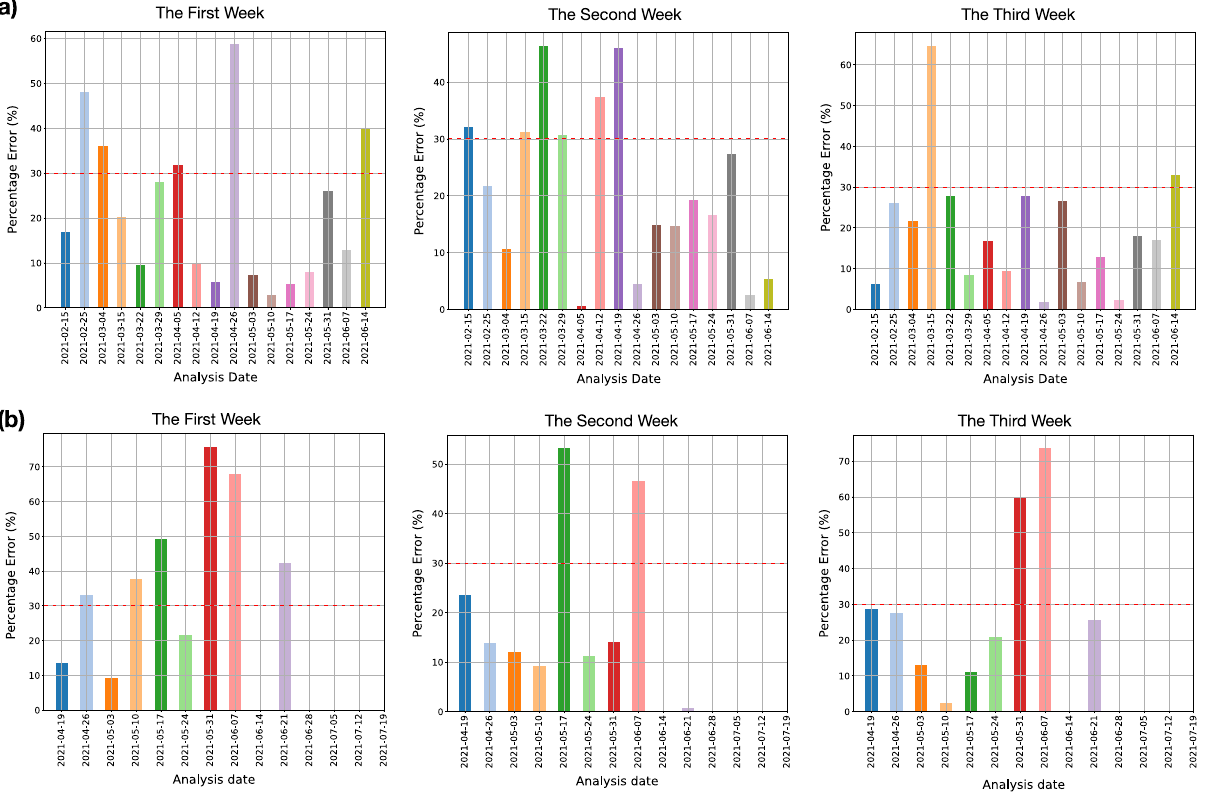
Figure 8. Error in prediction in terms of the percentage error score per analysis date. The duration of the forecast window of 21 days is partitioned into three parts, namely, the first week, the second week, and the third week. ( a ) Percentage error per partition and per analysis date, averaged across 7 partition days, for SU and ( b ) for SÄS. Percentage errors are not shown for those analysis dates for which the total number of admitted patients were fewer than 15